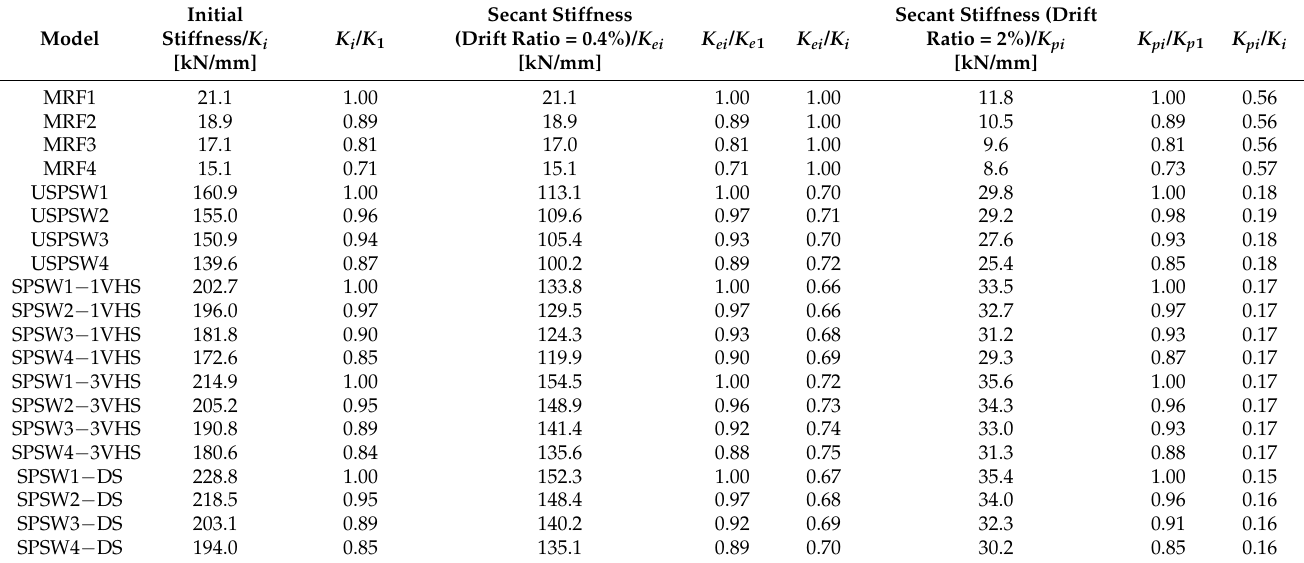
Table 6. Stiffness results for MRF, USPSW, SPSW − 1VHS, SPSW − 3VHS, and SPSW − DS with variable column flexural